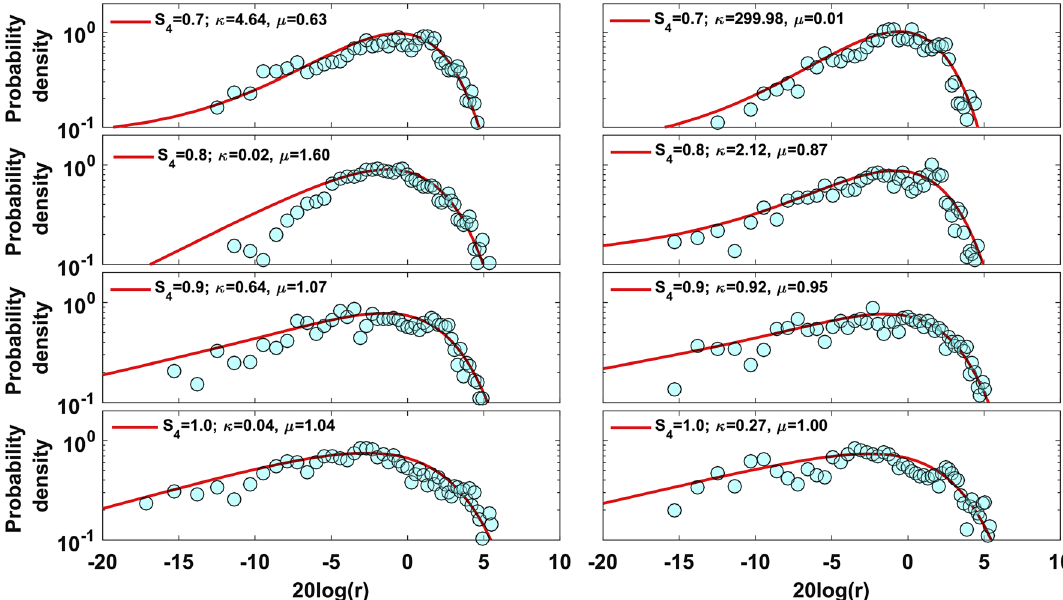
Fig. 8. Examples of empirical histograms versus the probability density function based on the j - l estimated values.